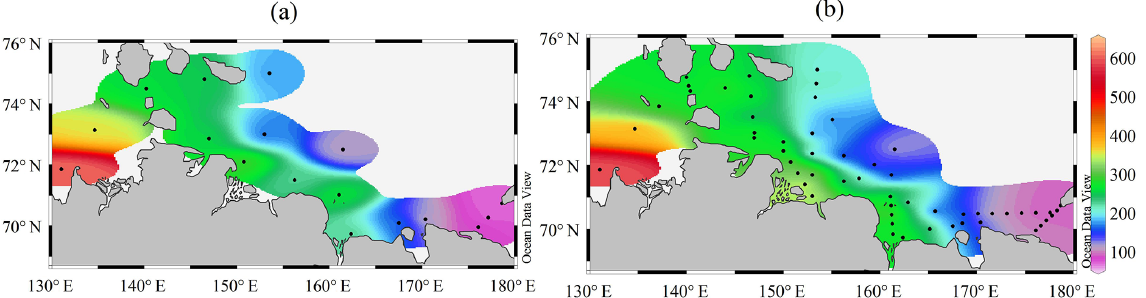
Figure 10. DOC distribution (µM) in the ESAS surface waters in September 2004: (a) measured DOC concentrations and (b) concentrations of DOC estimated from